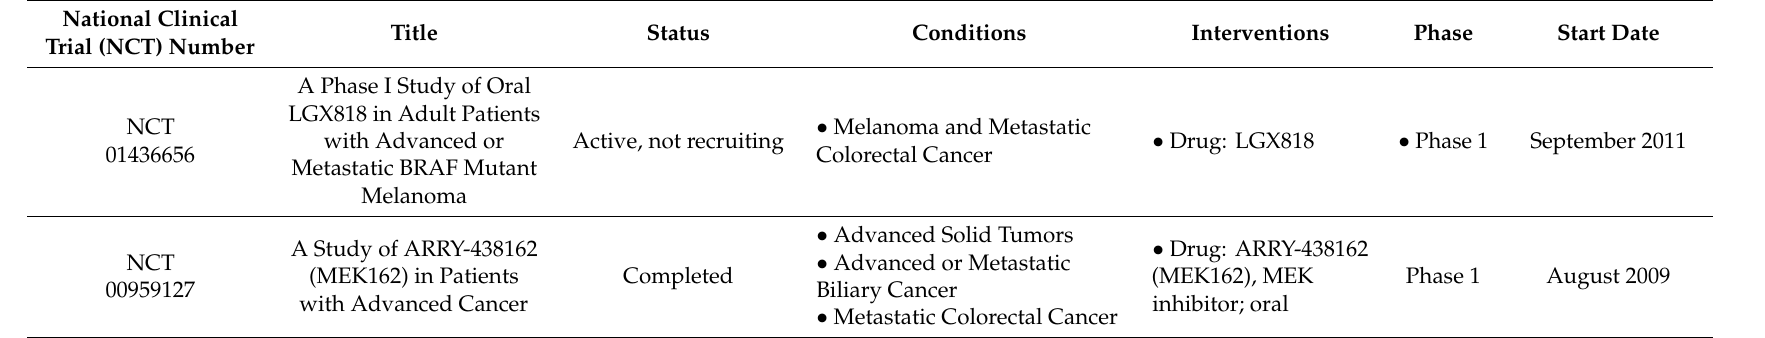
Table 7. Clinical trials of therapies targeting the MAPK pathway in patients with colorectal